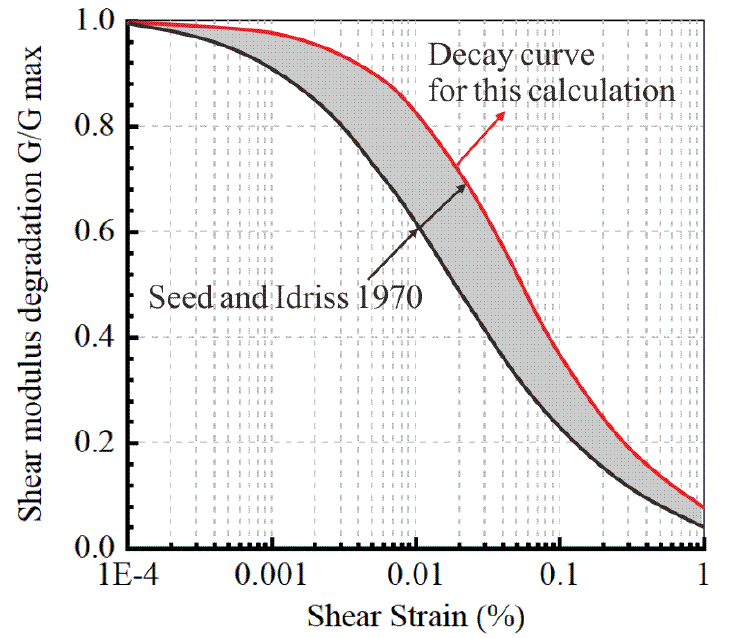
Figure 5. Shear modulus reduction curve for sand compared with Seed and Idriss (1970) [26] .